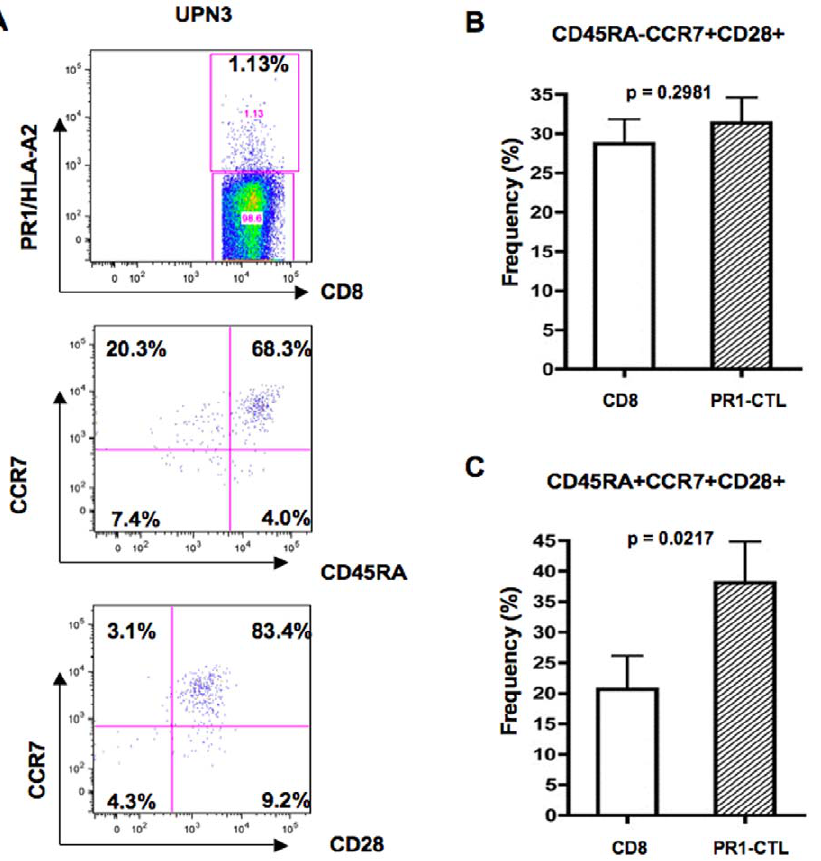
Figure 3. PR1-CTL express all T cell differentiation phenotypes. A cocktail of antibodies with 8 fluorochromes was used to label PBMC with anti-CD8, lineage markers (Lin; anti-CD4, anti-CD14, anti-CD16, anti-CD19), CCR7, CD27, CD45RA, CD28, CD57 and PR1/HLA-A2 tetramer. The data was analyzed using the FlowJo analysis software. (A) Gating was done on CD8 + Lin- lymphocytes in the upper panel and on PR1-CTL in the center and lower panels. The center and lower panels show the representative phenotype of naı¨ve and memory PR1-CTL from patient 3. The percentage of PR1/ HLA-A2 tetramer-negative and PR1/HLA-A2 tetramer-positive CD8 + cells that express (B) central memory or (C) naı¨ve phenotype averaged from patients 1 to 7 is shown. P-values were calculated using a two-tailed t-test and results are shown as mean 6 SEM.